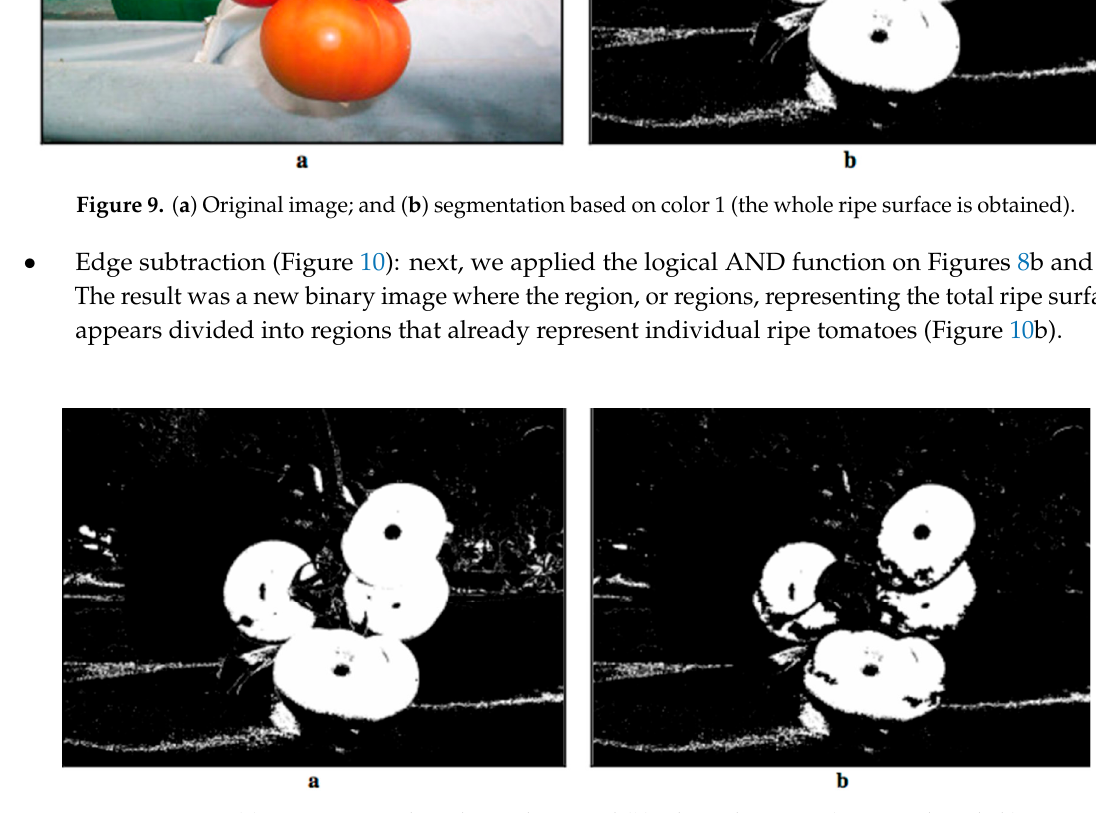
Figure 10. ( a ) Segmentation based on color 1; and ( b ) edge subtraction (Figure 8b and Figure 9b).